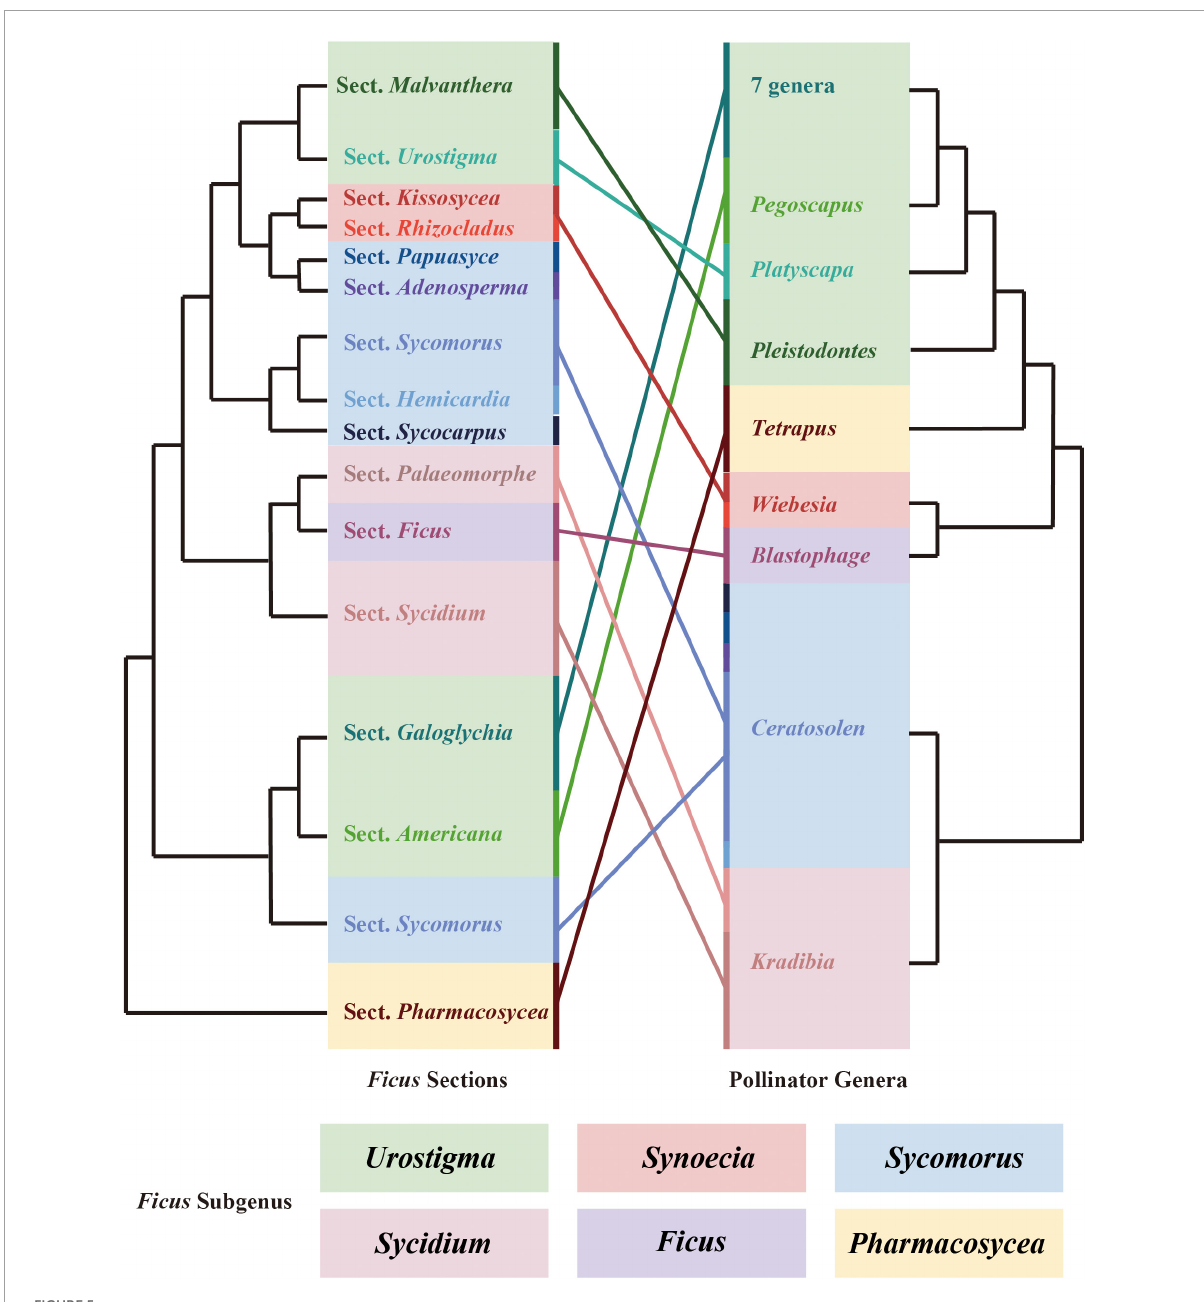
FIGURE5 Cophylogenetic comparison of sections of Ficus and genera of pollinating wasps. Both phylogenetic trees were pruned. Colored boxes indicate the subgeneric classification of Ficus . Colored lines connect the sections of Ficus and their related genus of pollinators.